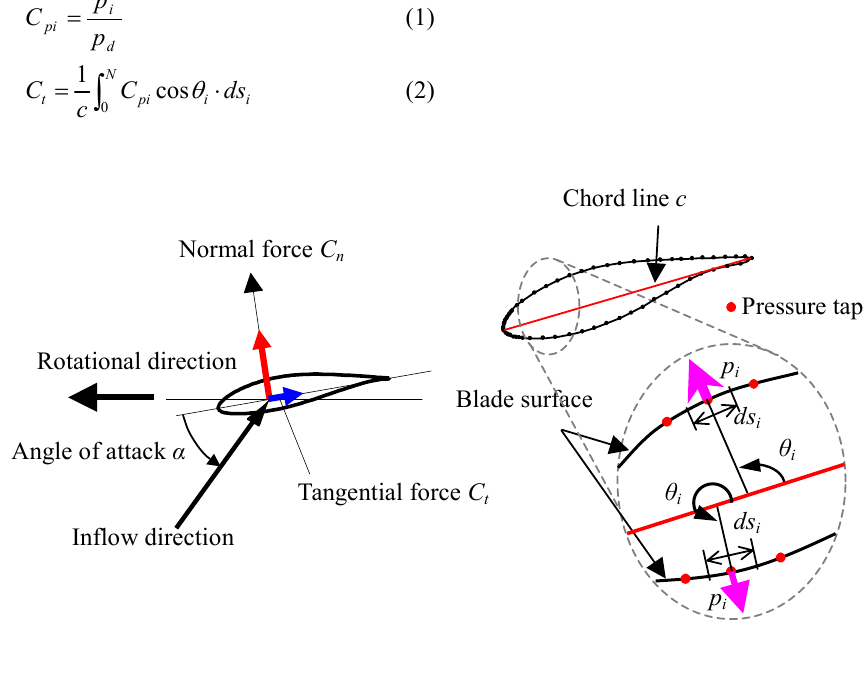
Figure 4. Aerodynamic forces acting on the blade